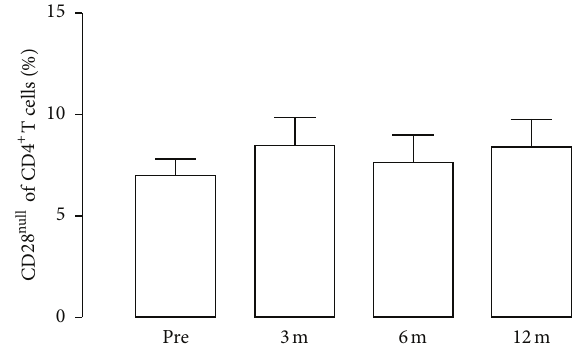
Figure 2: The percentage of CD4 + CD28null T cells after kidney transplantation. On the 𝑦 -axis the percentage of CD4 + CD28null cells is given in relation to time after kidney transplantation (given in months) and before transplantation (pre) in 30 patients.